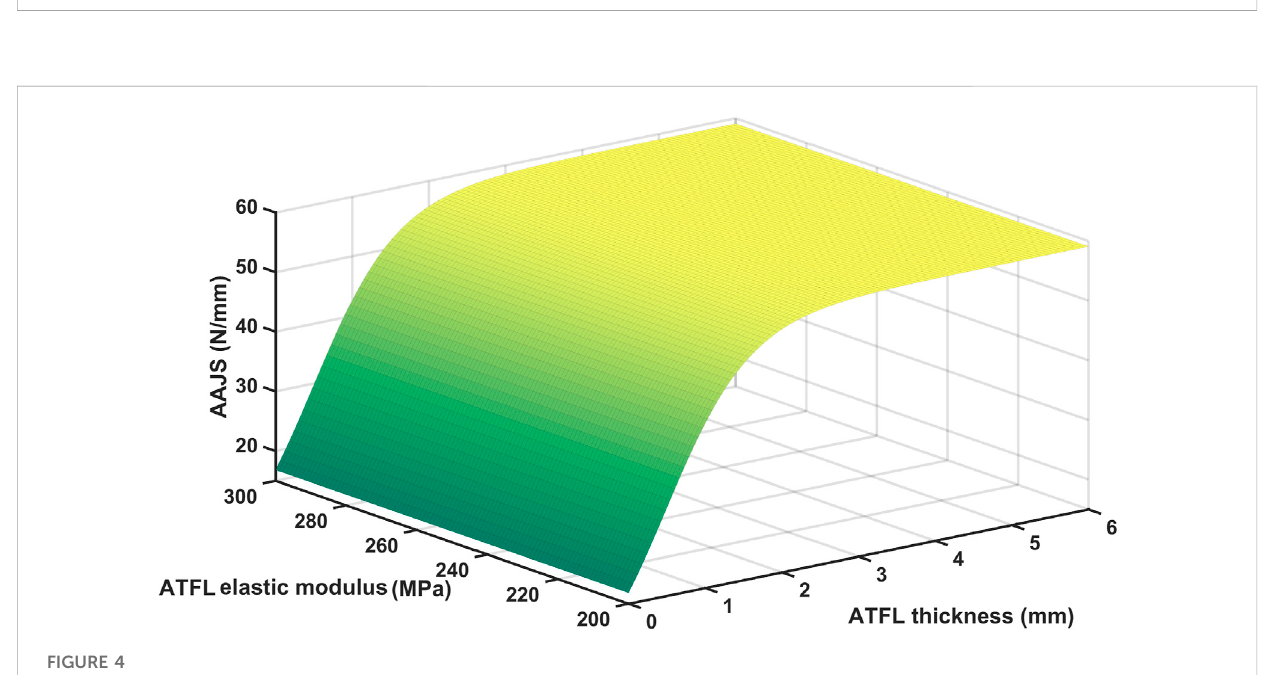
FIGURE 4 AAJS with different ATFL elastic modulus and